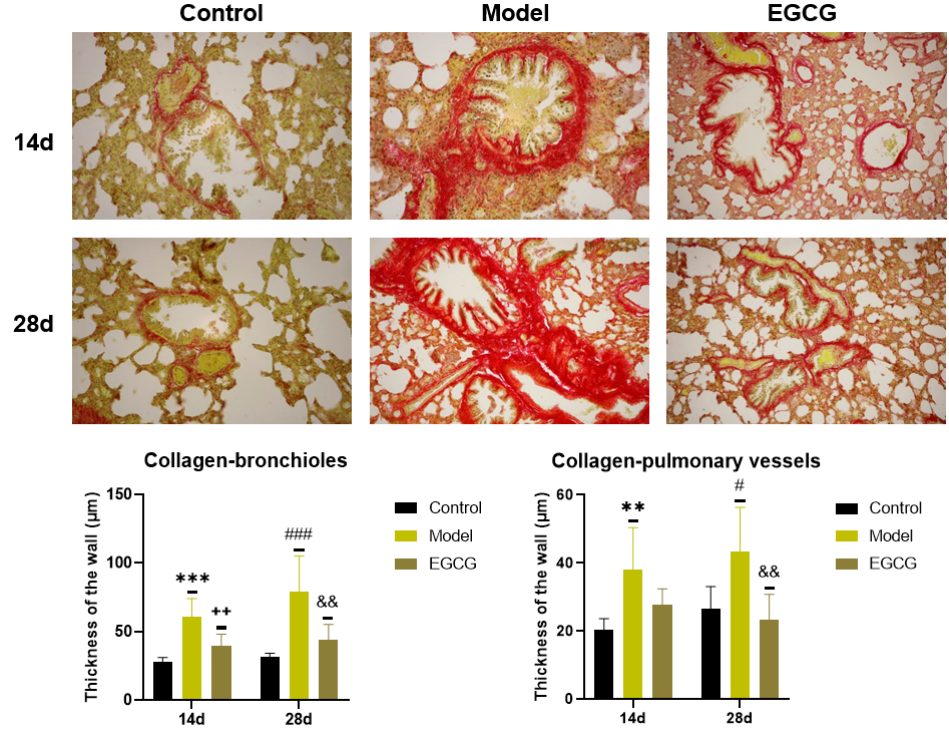
Figure 4. Immunohistochemical determination of the collagen presence in the lung of saline ‐ instilled animals (Control), silica ‐ instilled non ‐ treated animals (Model), and EGCG ‐ treated silica ‐ instilled an ‐ imals (EGCG) after 14 days (14d) or 28 days (28d) of the treatment delivery. Presence of collagen was verified by using Sirius red staining and was expressed as a thickness of the walls of bronchioli and pulmonary vessels (in μ m). For statistical differences among the groups: ** p < 0.01 and *** p < 0.001 for Model14d vs. Control14d; ++ p < 0.01 for EGCG14d vs. Model14d; # p < 0.05 and ### p < 0.001 for Model28d vs. Control28d; && p < 0.01 for EGCG28d vs. Model28d. Detection of α‐ SMA, a marker of connective tissue accumulation, was performed us ‐ ing a specific α‐ SMA antibody. We found that the thicknesses of the bronchiolar walls ( p < 0.05 after 14 days, p < 0.01 after 28 days) and pulmonary vessels walls ( p < 0.05 after 14 days, p < 0.01 after 28 days) significantly elevated in the silica ‐ instilled animals compared to the saline ‐ instilled animals. Treatment with EGCG decreased a generation of the smooth muscle mass in the bronchioles (both p < 0.01 after 14 and 28 days) and pulmonary vessels (both p < 0.05 after 14 and 28 days) (Figure 5).